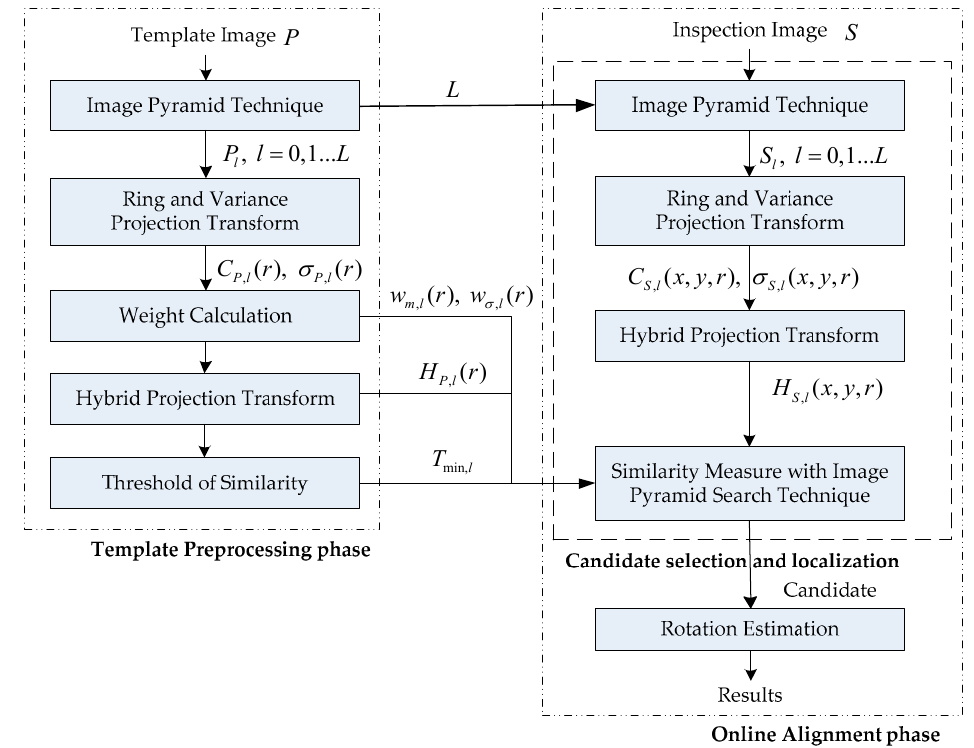
Figure 3. Architecture of the proposed algorithm.